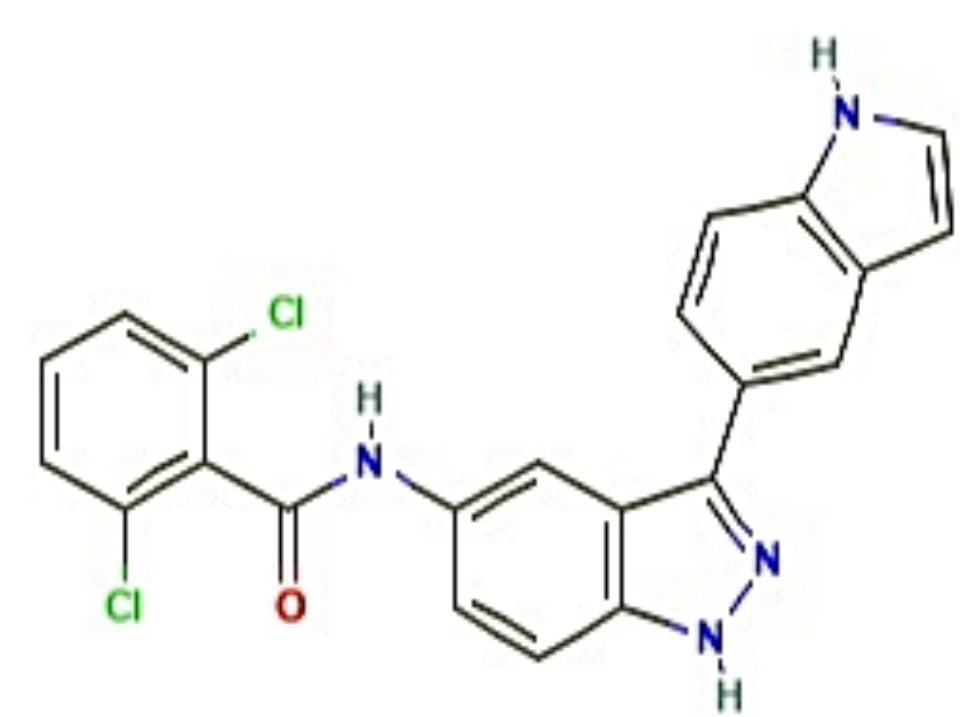
Figure 4. 2D structure of MD2-TLR4-IN-1 (PubChem ID: 138454798).